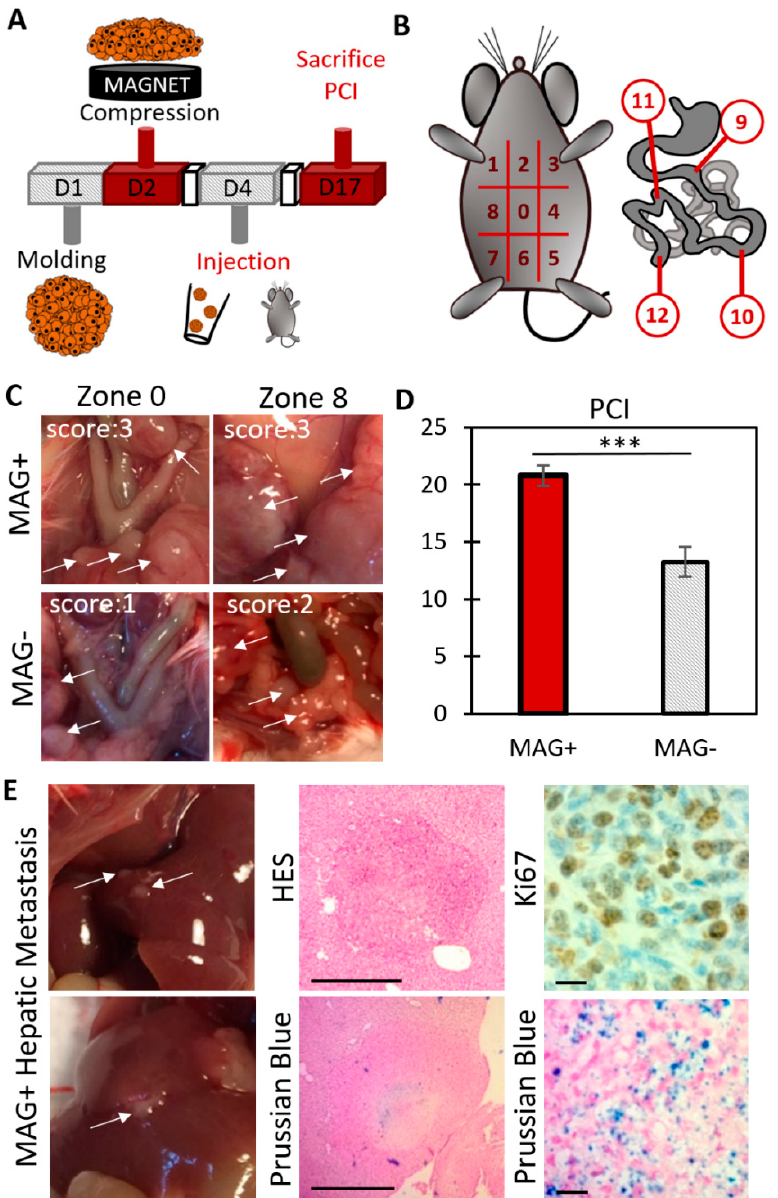
Figure 5. Evaluation of the carcinomatosis progression in mice injected with MAG+ or MAG − spheroids 3 days after their formation. ( A ) Overview of the experiment. Magnetically molded CT26 spheroids were cultured for two days upon magnet application (MAG+ spheroids) or without magnets (MAG − spheroids). Then, for each condition, 10 spheroids per mouse were injected into the peritoneum. Mice were sacrificed 13 days later, and the Peritoneal Carcinomatosis Index (PCI) was evaluated. ( B ) PCI evaluation: the peritoneum is divided into 13 regions. Depending on the number and size of the tumor nodules, a score between 0 to 3 is allocated for each region. The sum of the scores provides the PCI for each mouse. ( C ) Typical images during PCI analysis. The white arrows indicate tumor nodules. For the two regions of the MAG+ mouse, a score of 3 was allocated. Scores of 1 and 2 were allocated for the regions n °0 and n °8 of the MAG − mouse, respectively. ( D ) Average PCI for mice injected with MAG+ spheroids (red bar) and MAG − spheroids (striped bar). The mice injected with the compressed spheroids (MAG+) experienced an increase in cancer progression (two different experiments, in total n = 8 and n = 10 for MAG+ and MAG − , respectively, with *** signifying p < 0.005). ( E ) Immunohistological staining of hepatic metastasis (indicated with white arrows) in mice injected with MAG+ spheroids. The top middle picture shows hematoxylin– eosin staining (HES, cytoplasm and nucleus labeling) of a metastasis section of approximately 800 µm in diameter (scale bar = 500 µm). The bottom middle image shows a Prussian blue staining (iron